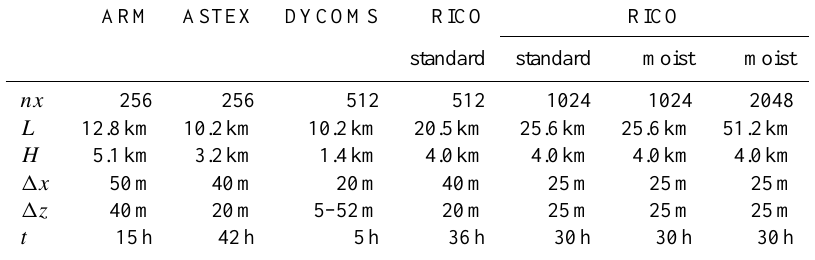
Table 1. Overview of the different LES cases used in this study. The four cases on the left hand side are used to develop (DYCOMS and RICO) and test (ARM and ASTEX) the parameterizations introduced in this study. The three cases on the right hand side are solely used in the Sect. 5. ARM ASTEX DYCOMS RICO RICO standard standard moist moist nx 256 256 512 512 1024 1024 2048 L 12.8km 10.2km 10.2km 20.5km 25.6km 25.6km 51.2km H 5.1km 3.2km 1.4km 1x 50m 40m 20m 40m 25m 25m 25m 1z 40m 20m 5–52m 20m 25m 25m 25m t 15h 42h 5h